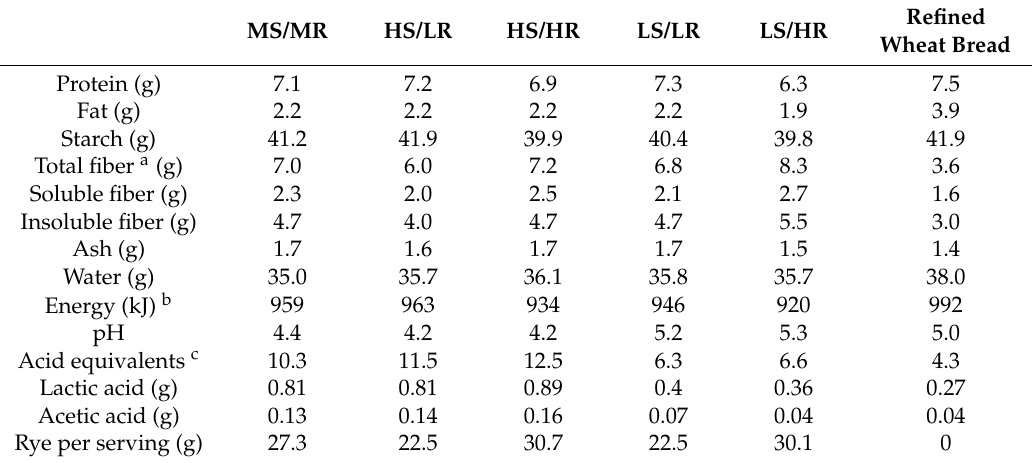
Table 2. Composition, energy content, pH and acids of breads per serving (100